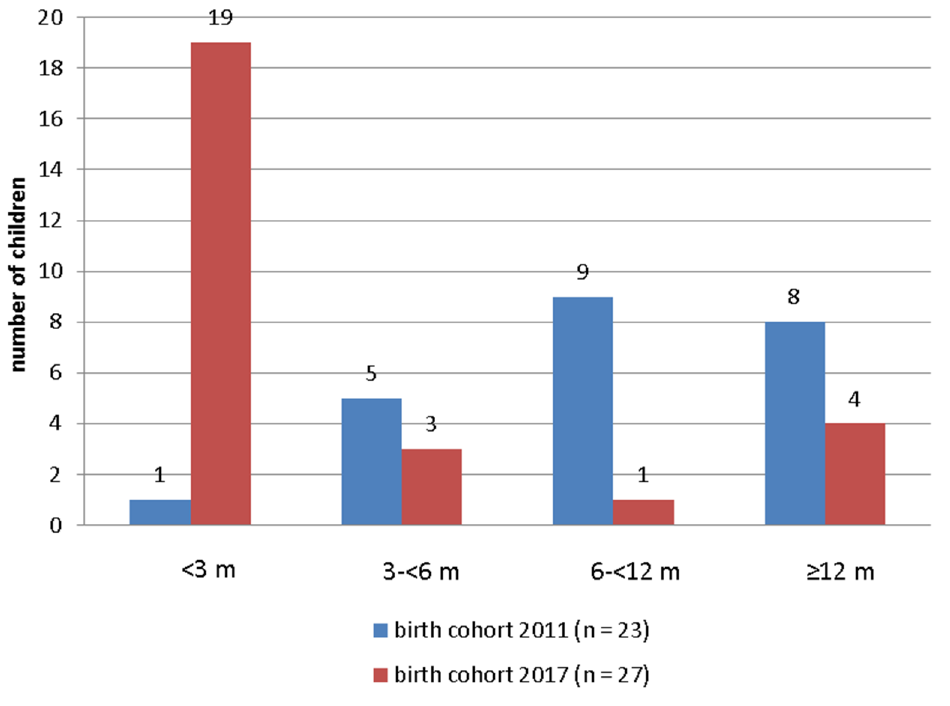
Figure 1. Comparison of age at enrolment in EI of birth cohorts 2011 and 2017. The comparison of age at enrolment in EI of the birth cohorts 2011 and 2017 (Figure 1) demonstrates a significant increase in the proportion of children younger than 6 months of age in the younger cohort after the introduction of the new NHS and tracking protocol (Mann–Whitney U = 94.0, p < 0.001). The percentage of children below the benchmark of 6 months increased from 26% (birth cohort 2011) to 81% (birth cohort 2017). The mean age at enrolment was reduced from 11.5 to 4.8 months (medians 7.8 to 2.0). The high number of children younger than 3 months of age at enrolment in EI ( n = 19; 70%) compared with only one child in the 2011 cohort (4.3%) is